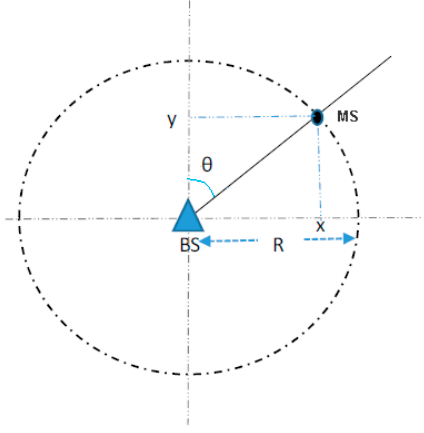
Figure 4. Obtaining the second coordinate for LOS scenarios [3].